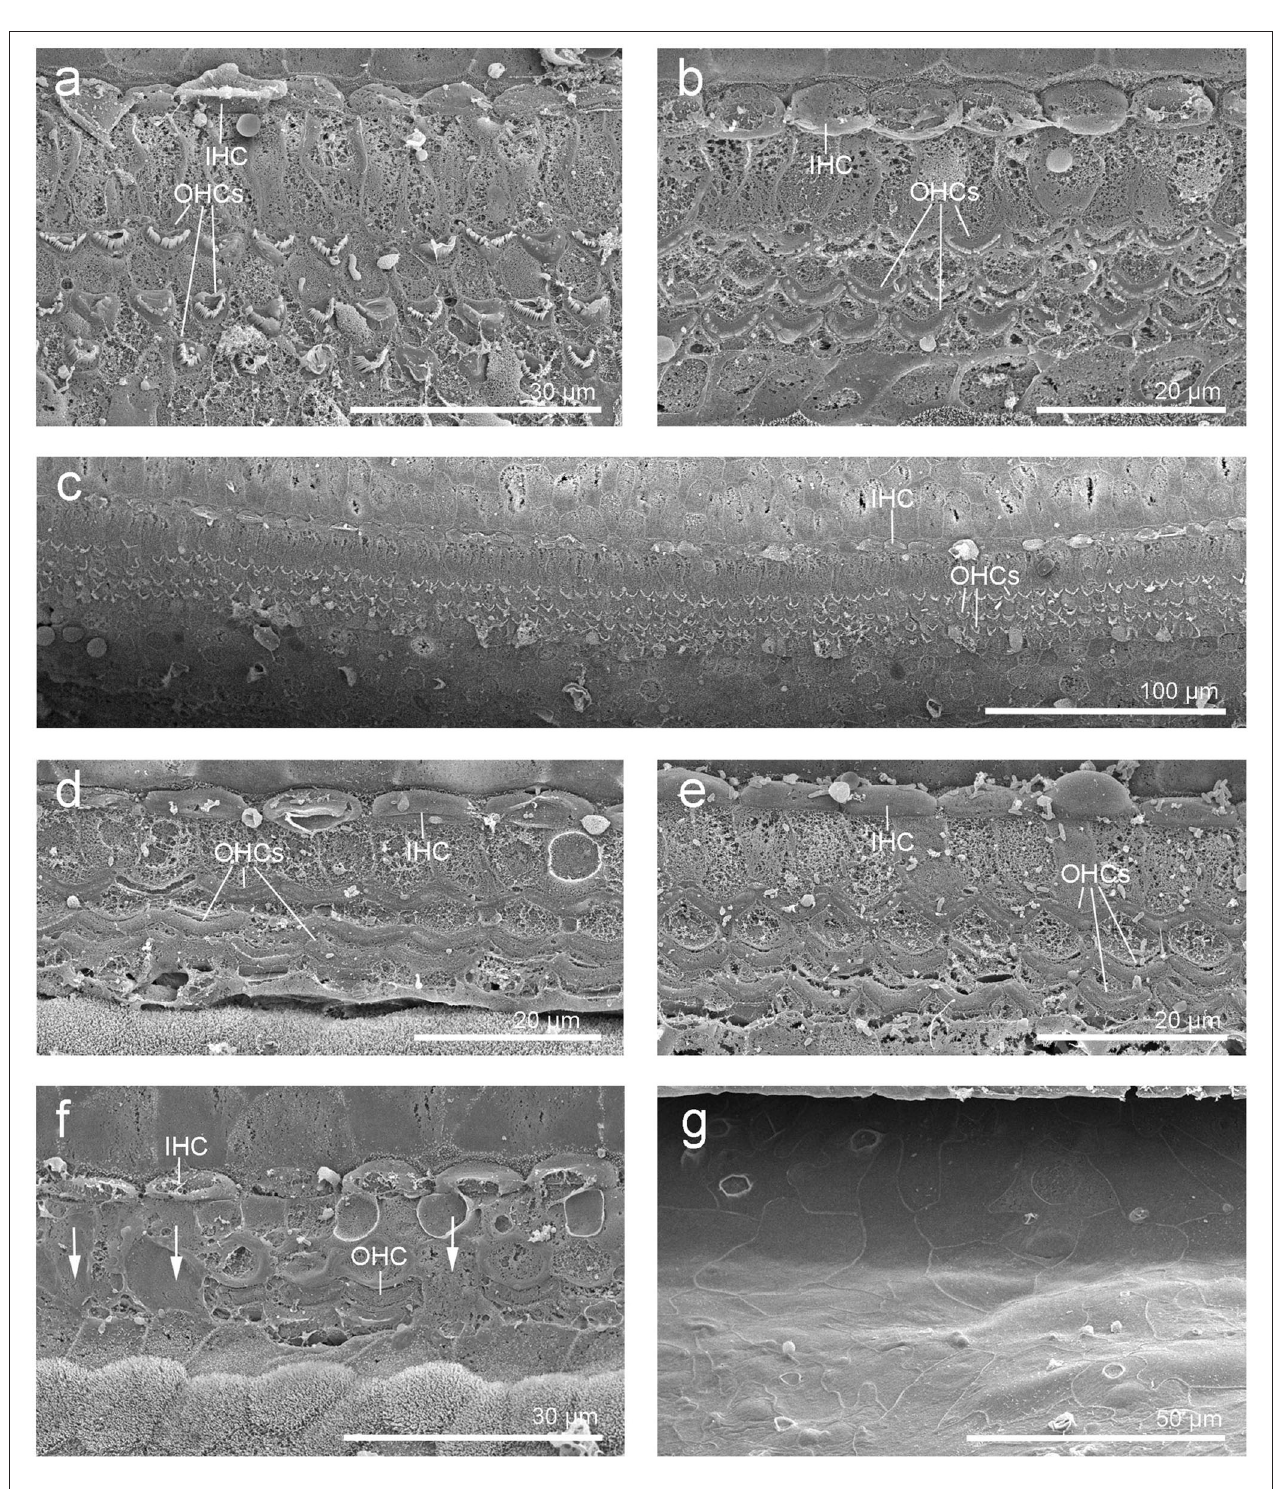
FIGURE 3 | Scanning electron micrographs of the left cochlea from the beluga Qila. Organ of Corti with three rows of outer hair cells (OHCs) and one row of inner hair cells (IHCs) in the upper (a) and lower (c) apical turn, upper (b) and lower (d–g) basal turn. (f) Area of transition with some scars (arrows). (g) Flat epithelium, present along the first 4.9mm of the base, where the highest frequencies are